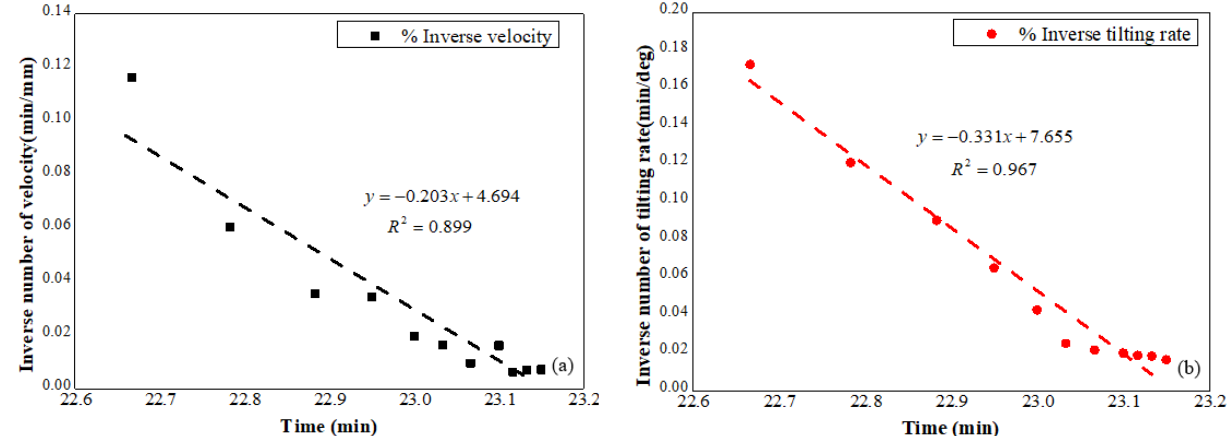
Figure 10. ( a ) Reciprocal displacement rate against time, ( b ) reciprocal tilting rate against